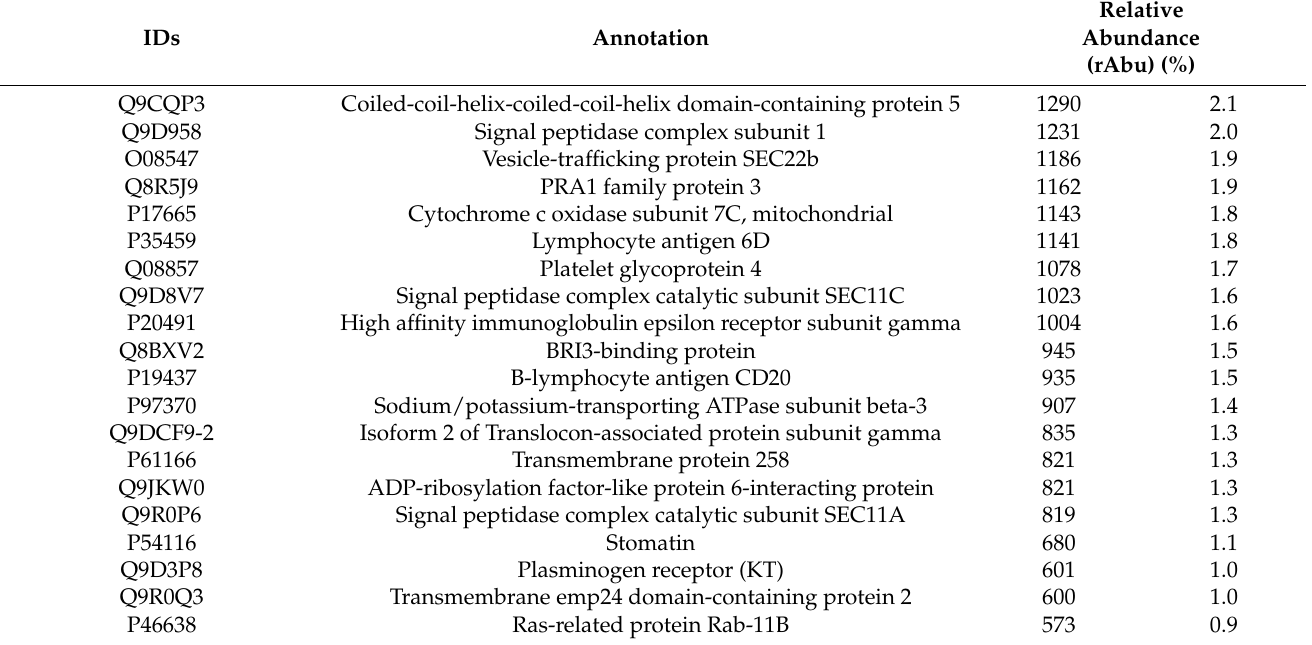
Table 2. List of most abundant 6027-specific binding proteins in mouse spleen cell-free extracts. The IDs correspond to Uniprot entries (www.uniprot.org). The ORF numbers correspond to Uniprot entries (www.uniprot.org). Their relative abundance is given as a parameter taken from the dataset (see Tables S1 and S4), as well as a percentage of the peptide 6027 specific binding proteins. The full list of proteins is given in Table